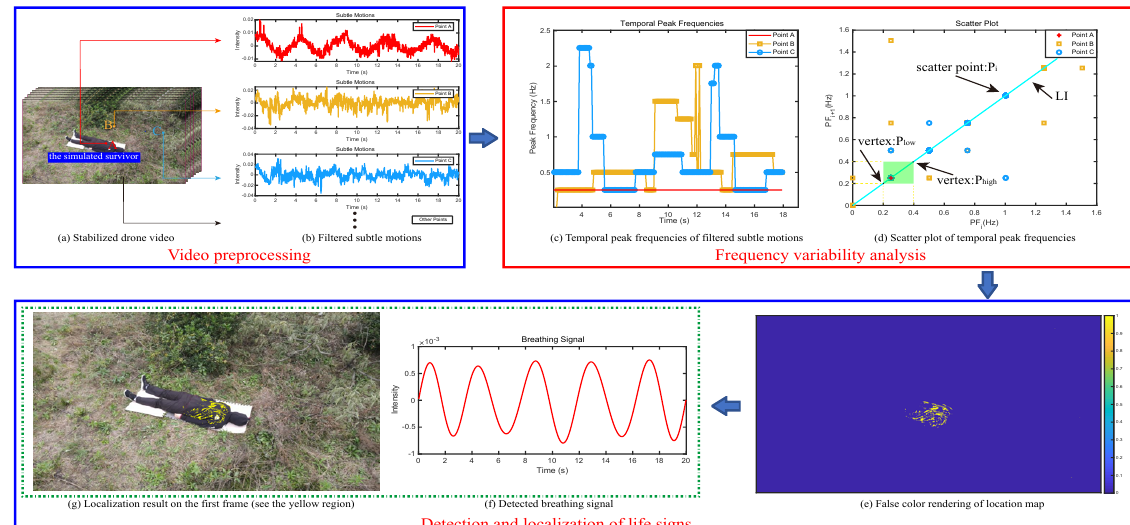
Figure 1. Overview of the frequency variability feature-based method for detection and localization of life signs in natural